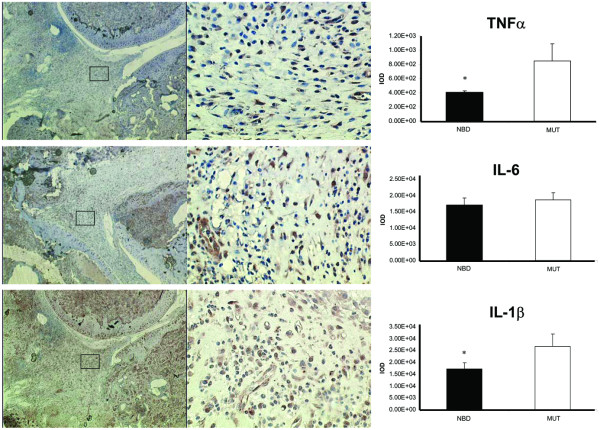
Intra-articular NBD treatment results in decreased pro-inflammatory cytokine expression. Shown are representative overview images of mutant NBD (MUT)-treated ankle joints. Expression of different cytokines was evaluated by immunohistochemical staining of paraffin-embedded ankle joints. Detailed images of synovial cytokine staining are provided (boxes in upper panels indicate synovial tissue location), followed by results from digital image analysis (n = 10/group). Tumor necrosis factor (TNF)-α and interleukin (IL)-1-β expression was significantly reduced in the NBD-treated group as compared with the MUT-treated group (*p = 0.05 and *p = 0.04, respectively). Data represent mean ± standard error of the mean.